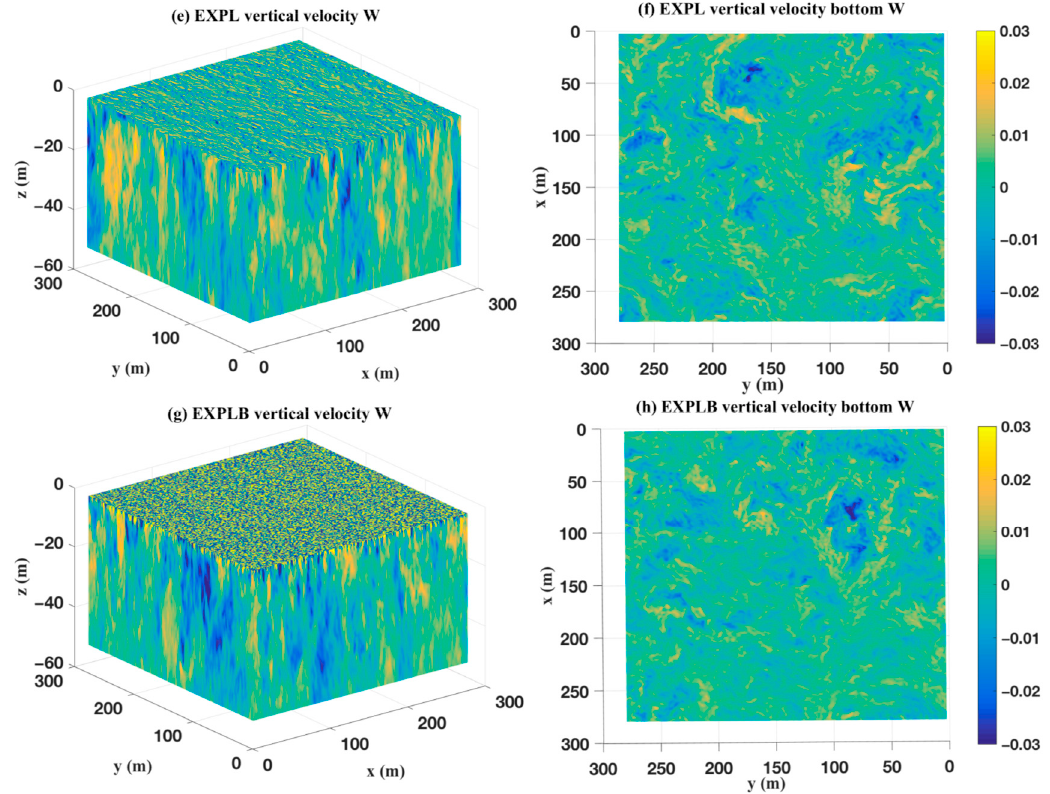
Figure 1. Distributions of three-dimensional vertical velocity (m/s) without Langmuir circulation (LC) and breaking waves (BW) ( a ); with only BW ( c ); with only LC ( e ) and with LC and BW ( g ). Horizontal cross-section of vertical velocity (z = 51 m) without LC and BW ( b ); with BW ( d ); with LC ( f ); with LC and BW ( h ).